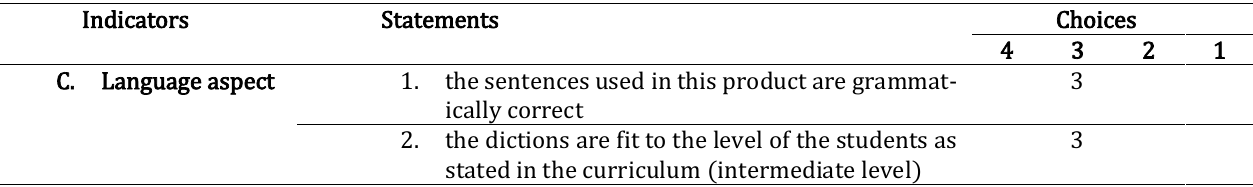
Table 4. The result of validation for the language aspect of the prototype of teaching materials for Linguistics Description of